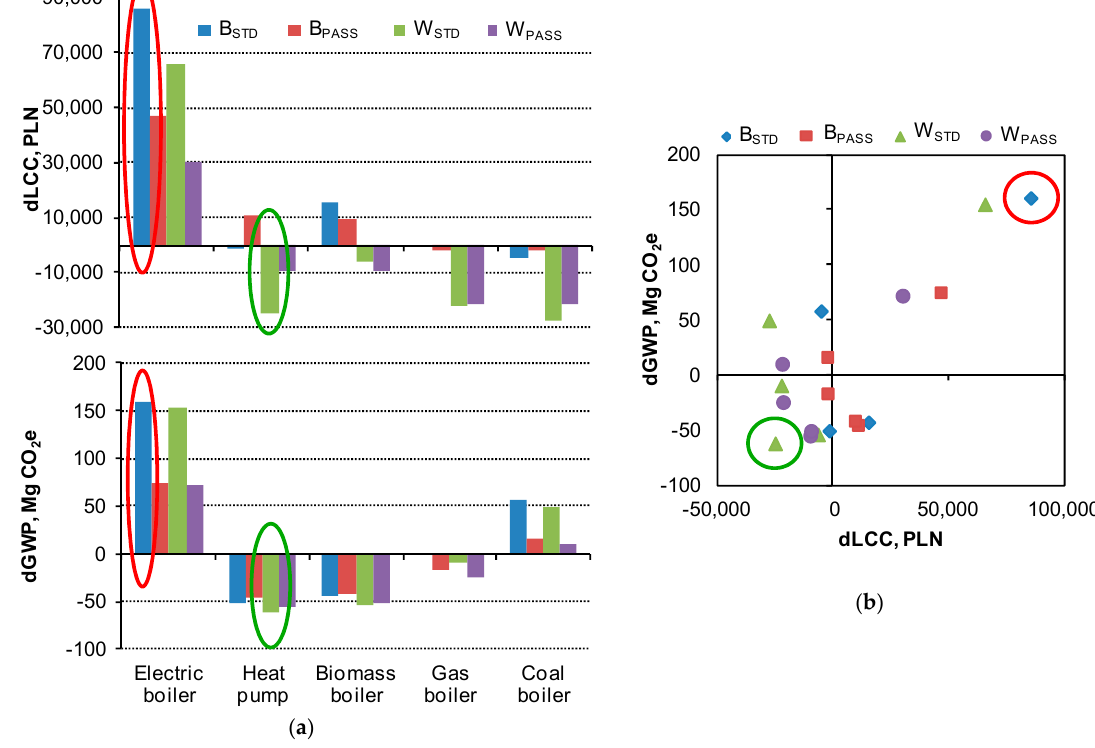
Figure 8. The difference between the buildings’ life cycle costs (dLCC) and GHG emissions (dGWP) compared to a standard brick building (B STD ) with ( a ) a gas boiler and ( b ) their correlation.